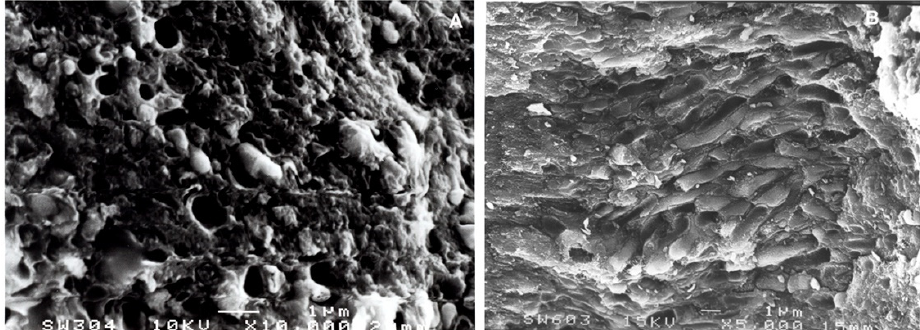
Figure 3. Combe Grenal IV. ( A ): (picture 308), tartar bacteria at 20,000 SEM magnification. ( B ): Kebara 2 (picture 603), tartar bacteria at 5000 SEM magnification.